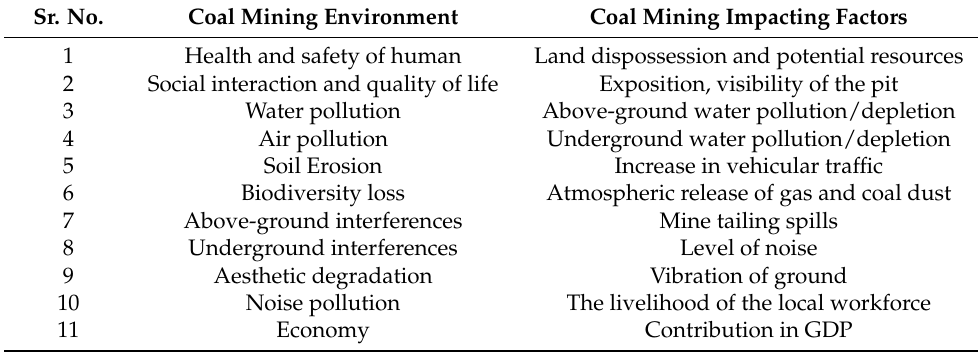
Table 1. Mining environment categories and impact factors. Sr.